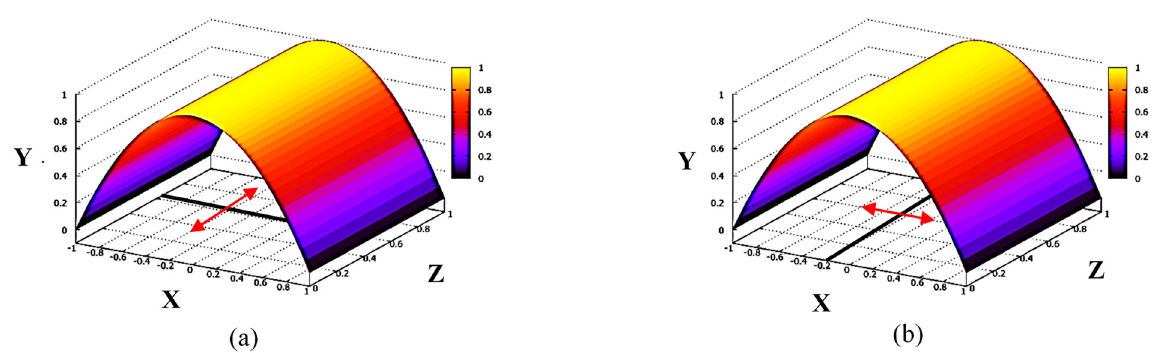
Figure 6. Orientation of split-line and secondary beam displacement: ( a ) beam displacement in Z direction with split-line parallel to X axis, and ( b ) beam displacement in X direction with split-line parallel to Z axis.